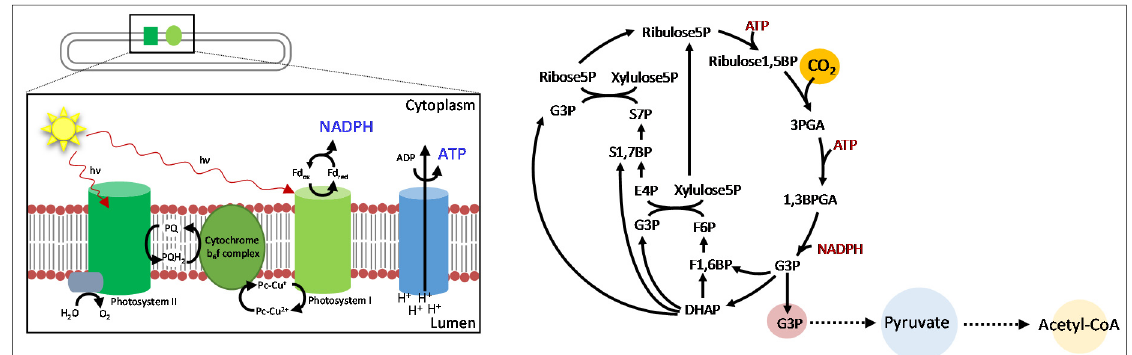
Figure 1. Schematics of cyanobacterial central metabolism. NADPH and ATP are generated through light reactions. Subsequently, they are used to convert CO 2 into central metabolites, which can be used for biochemical